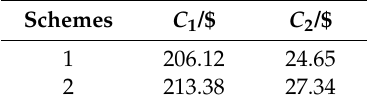
Figure 10. SOCs of ESS in Subcase 2. Table 7. Cost comparison of two schemes.